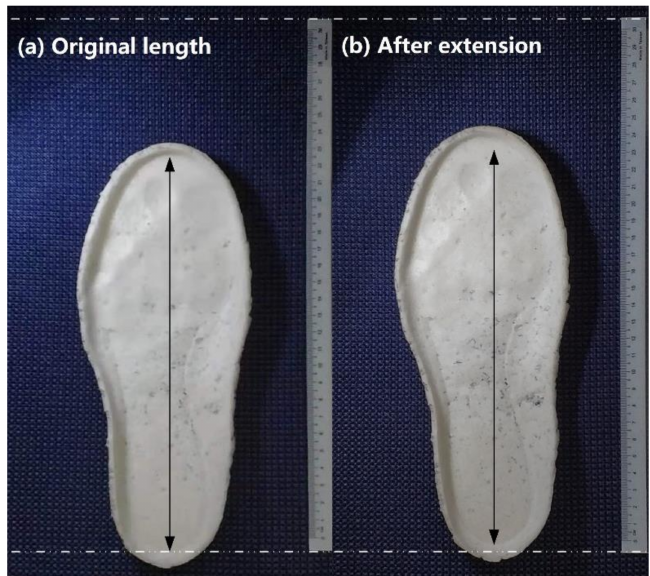
Figure 21. Body-temperature programming of shape memory sponge sole. ( a ) After body- temperature stepping on it (footprint captured); ( b ) after body-temperature